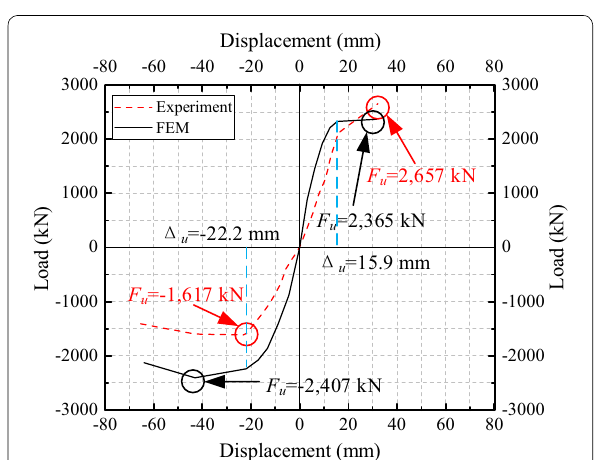
Fig. 23 Comparison of the low-reversed cyclic loading